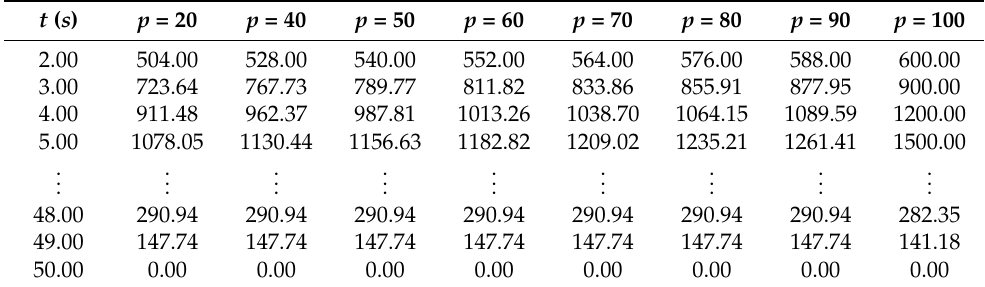
Table 4. Partial data of q when p takes different values.